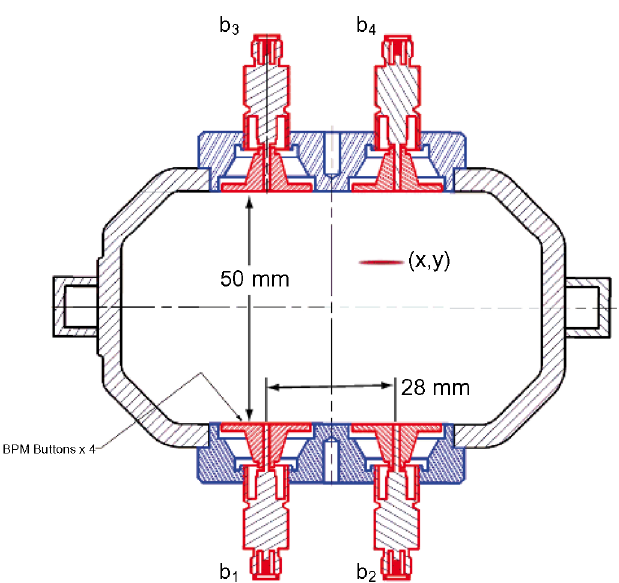
FIG. 1. CESR beam position monitor. Note labeling of